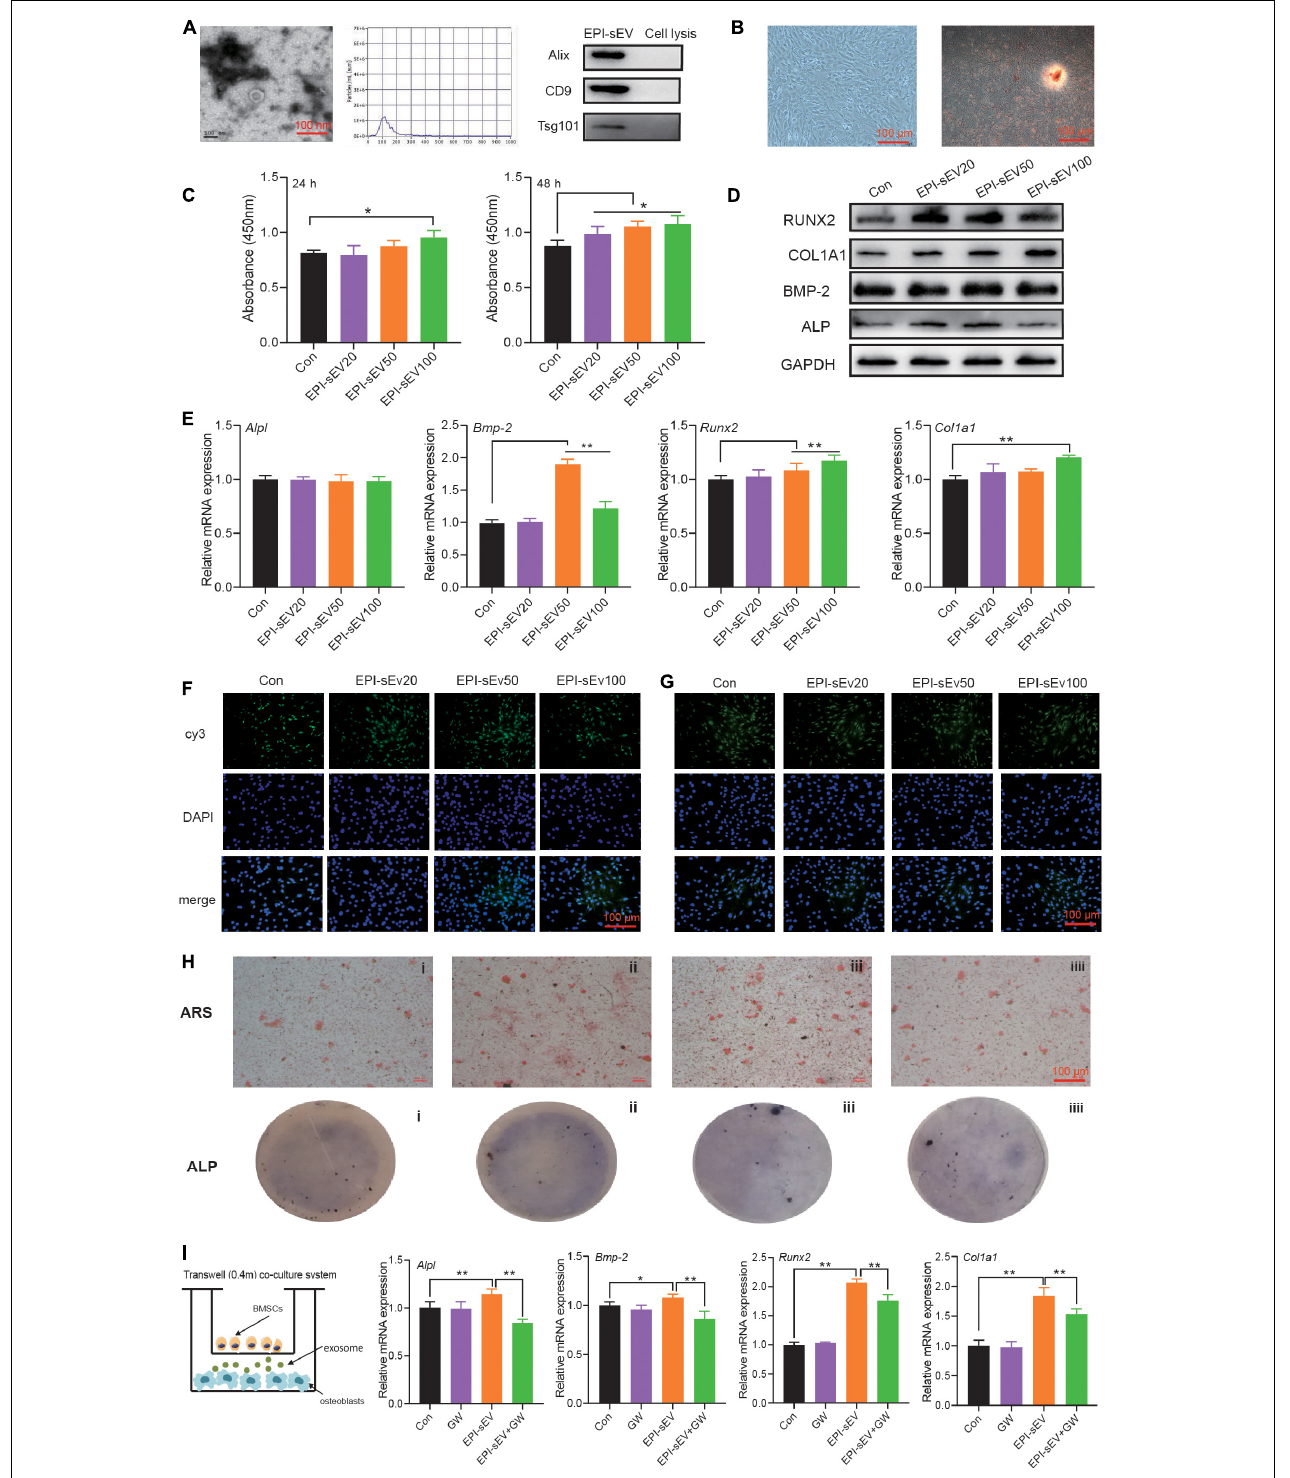
FIGURE 2 | Identification of EPI-sEV and the effect of EPI-sEV on osteogenic differentiation in osteoblasts. (A) Characterization of EPI-sEV using TEM, NTA, and Western blot; scale bar: 100 nm. (B) Identification of osteoblasts using morphology observation and Alizarin Red S staining; scale bar: 100 µ m. (C) The effects of different EPI-sEV concentrations on osteoblasts proliferation. Un-sEV: sEVs derived from untreated BMSCs; EPI-sEV20: 20 g/L EPI-sEV, EPI-sEV50: 50 g/L EPI-sEV, and EPI-sEV100: 100 g/L EPI-sEV. (D) The protein expression of osteogenic differentiation-related factor with different concentrations of EPI-sEV. (E) The mRNA